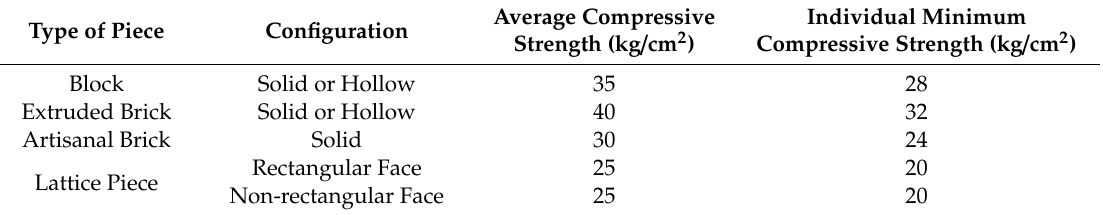
Table 5. Compressive strength values for Mexican standards.